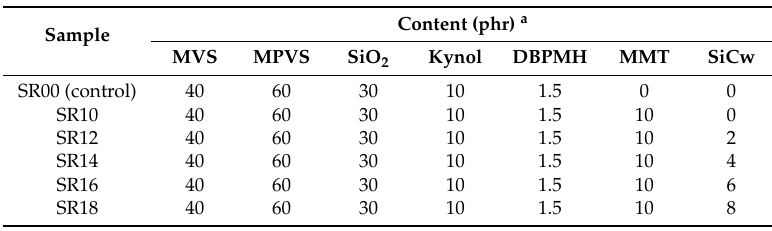
Table 1. Formula of the silicone rubber (SR) composites. MVS: Methyl vinyl silicone rubber; MPVS: methyl phenyl vinyl silicone rubber; DBPMH: 2,5-bis(tert-butyl peroxy)-2,5-dimethyl hexane; MMT: montmorillonite.